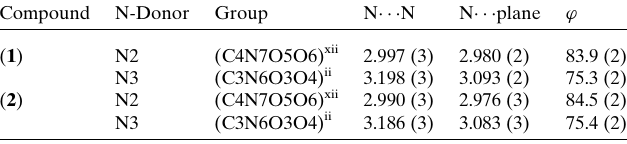
Table 3 Geometry of lone pair– (cid:3) -hole interactions (A˚ , (cid:5) ) in ( 1 ) and ( 2 ). N (cid:2)(cid:2)(cid:2) plane is a distance of an N-donor to the mean plane of a nitro group and ’ is an angle of the N (cid:2)(cid:2)(cid:2) N axis to the plane of the nitro group. Compound N-Donor Group